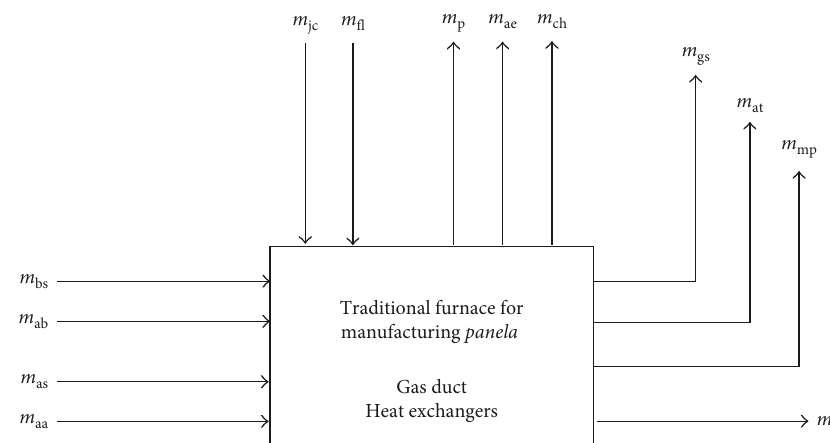
Figure 2: Traditional furnace mass balance, mass in kg. m bs : dry bagasse (husk), m ab : quantity of water in the bagasse (moisture), m as : dry air for combustion, m aa : water inlet with the air, m jc : mass of sugarcane juice, m fl : flocculant extract, m p : noncentrifugal brown sugar ( panela ) obtained, m ae : water evaporated during the concentration, m ch : mud removed from clarification, m gs : dry combustion gases leaving through chimney, m at : steam that accompanies the gases through the chimney, m mp : particulate material, and m r : unburned cinder collected from the traditional furnace